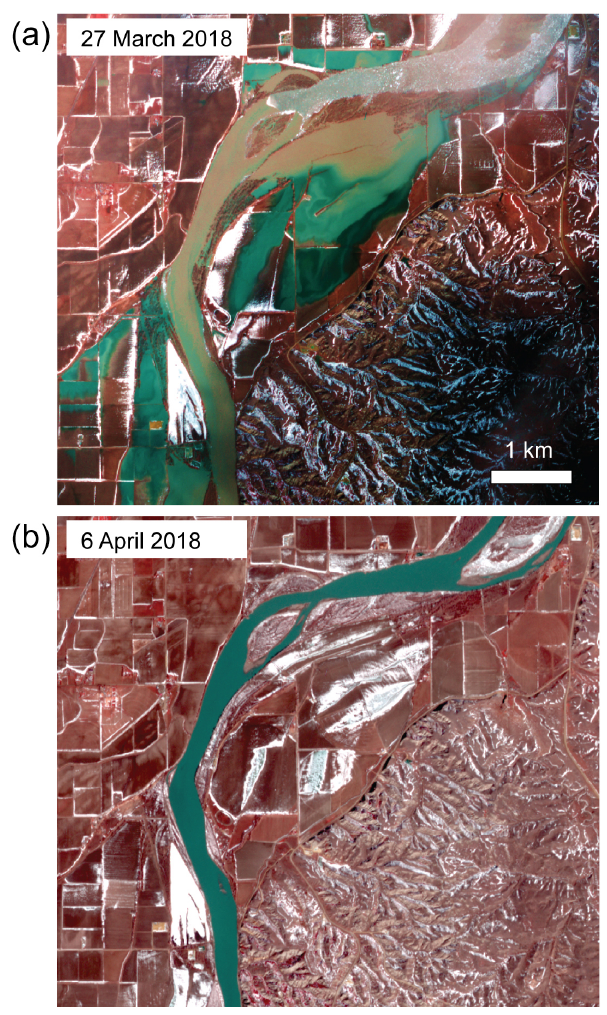
Figure 1. Planet images over an ice jam on the Yellowstone River at Sidney, Nebraska, USA (47.75 ◦ N, 104.09 ◦ W). The river flows from bottom to top (north). (a) The ice jam (top) and associated flooding. (b) After break of the ice